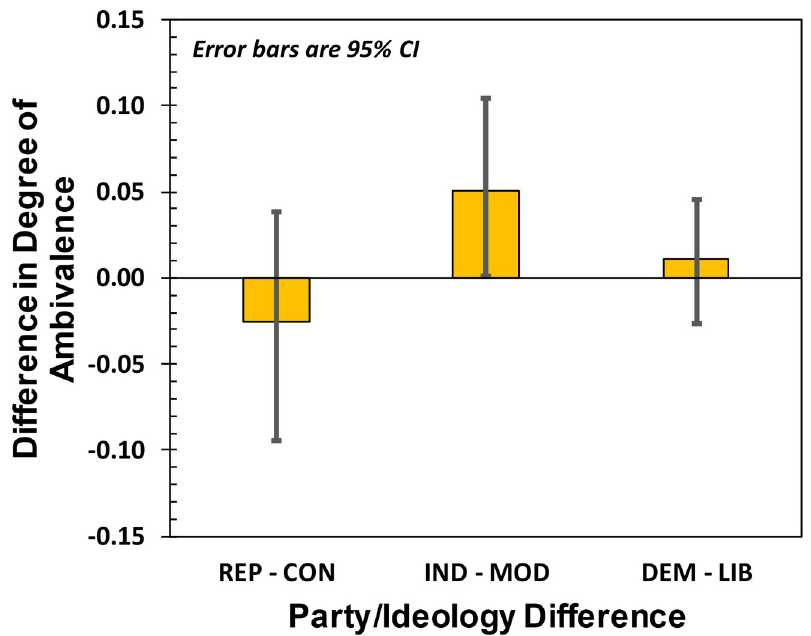
Fig 7. Difference in degree of ambivalence, D between party affiliation and the corresponding political ideology.